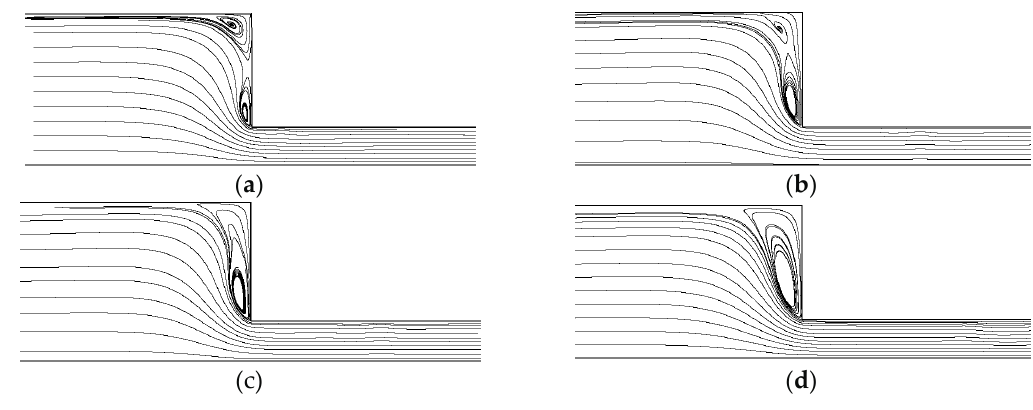
Figure 9. The instantaneous streamlines of the flow with Wi = 5.0: ( a ) t = 8, ( b ) 16, ( c ) 24, ( d ) 30.